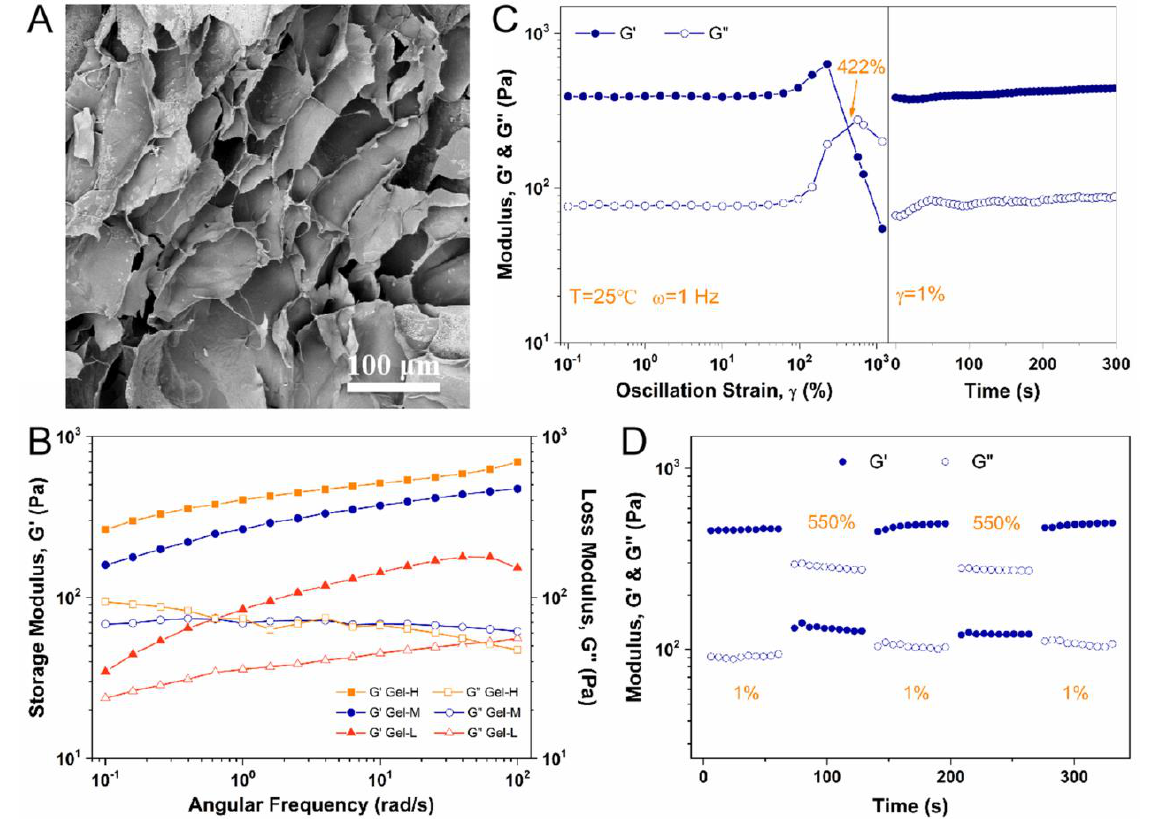
Figure 2. ( A ) Porous micro-structure of Alg-BOB hydrogel observed by SEM. ( B ) Mechanical strength of hydrogels prepared at different pH. ( C ) Oscillatory strain sweep from 0.1% to 1000% followed by an immediate time sweep for 300 s. ( D ) Step strain sweep at a low strain of 1% and a high strain of 550%.